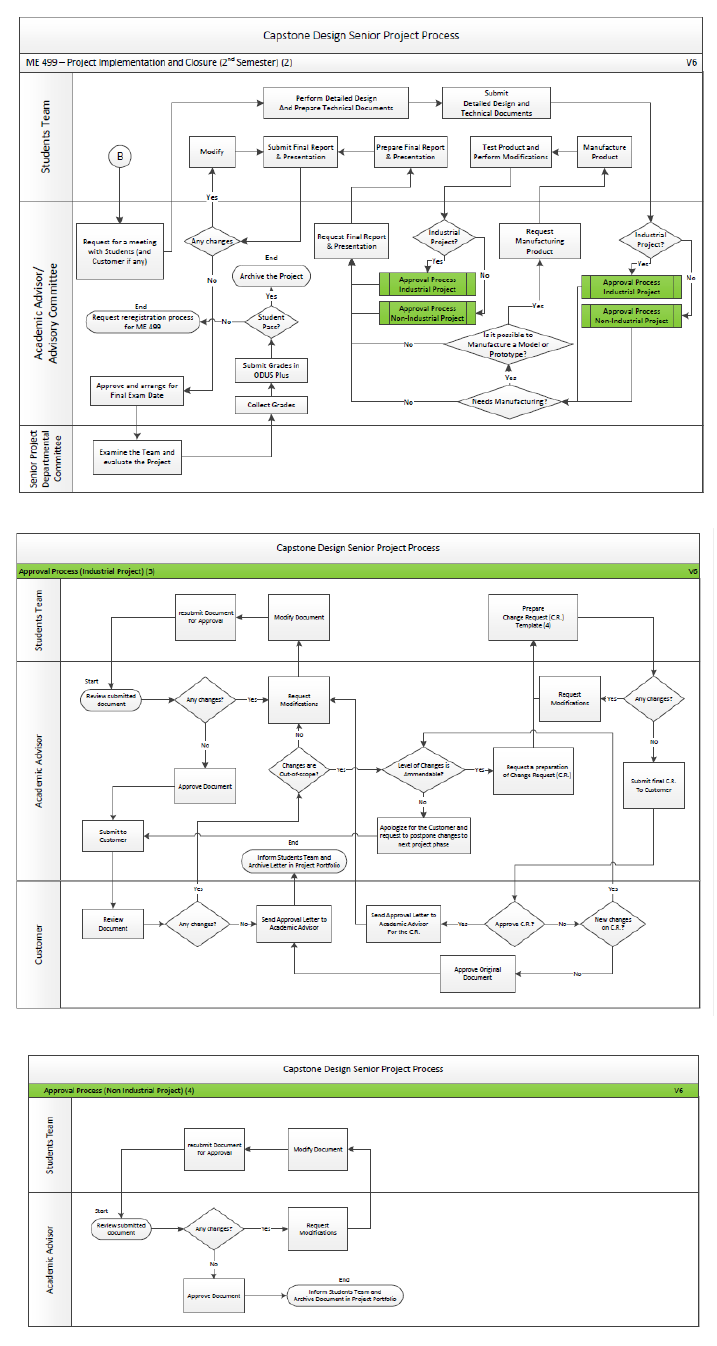
Fig. 4. Flow chart for the Senior Project Design with industry